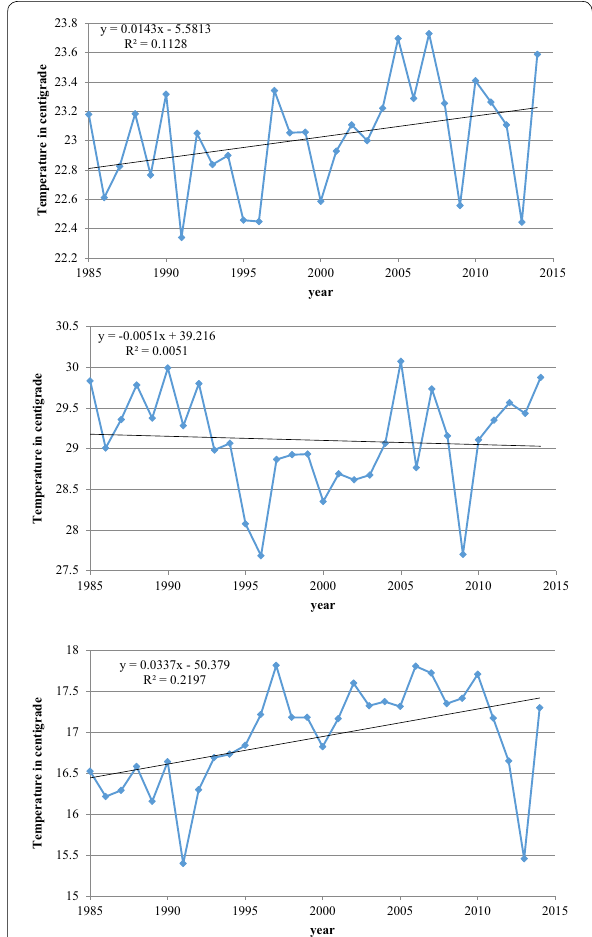
Fig. 15 30 years’ maximum, minimum and mean temperature trend for Khairinitar